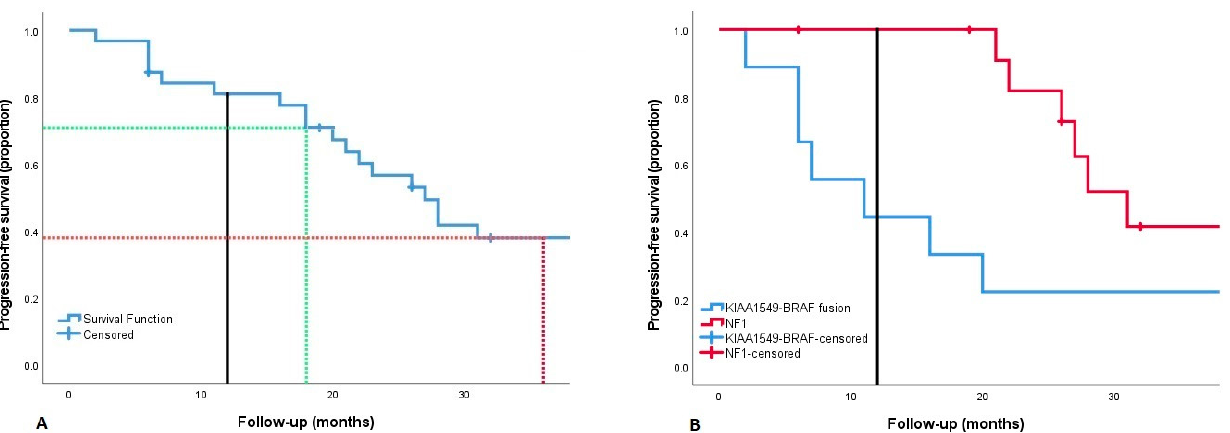
Figure 1. Kaplan–Meijer plot of progression-free survival for OPG treatment with BVZ. ( A ): Cumulative PFS overall population after start of treatment with BVZ for OPG: PFS reduces from 70.9% to 38.0% from 18 (green reference line) to 36 months (red reference line) after start (presumed 6 and 24 months after intended cessation of therapy). ( B ): Cumulative PFS between the NF1 ( n = 13) and KIAA1549-BRAF fusion positive population ( n = 9) (log rank: p < 0.01). Black line: reference line at 12 months: median completion of therapy cycles. Abbreviations: BVZ; bevacizumab, PFS: progression-free survival.